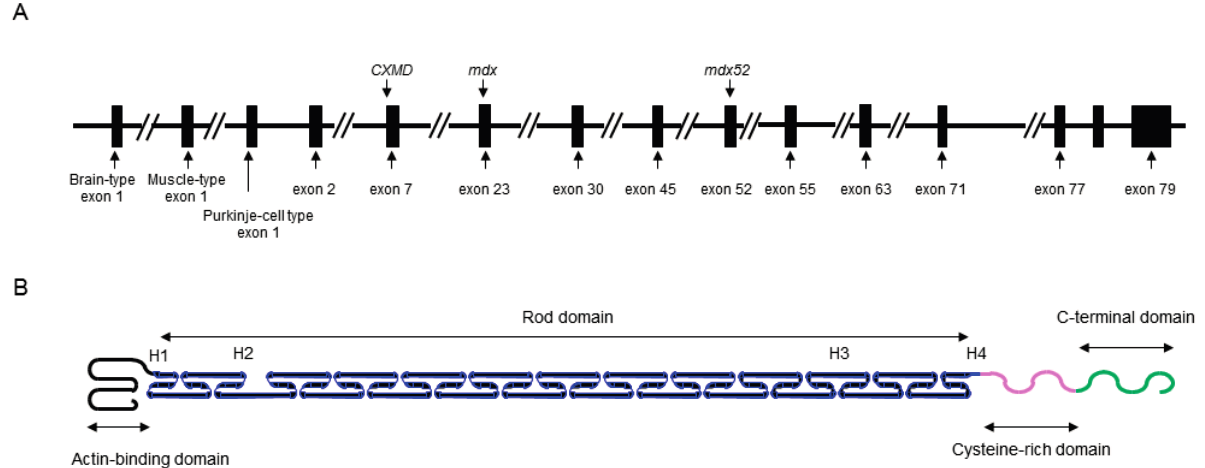
Figure 1. Schematic illustrations of the DMD gene and molecular structure of